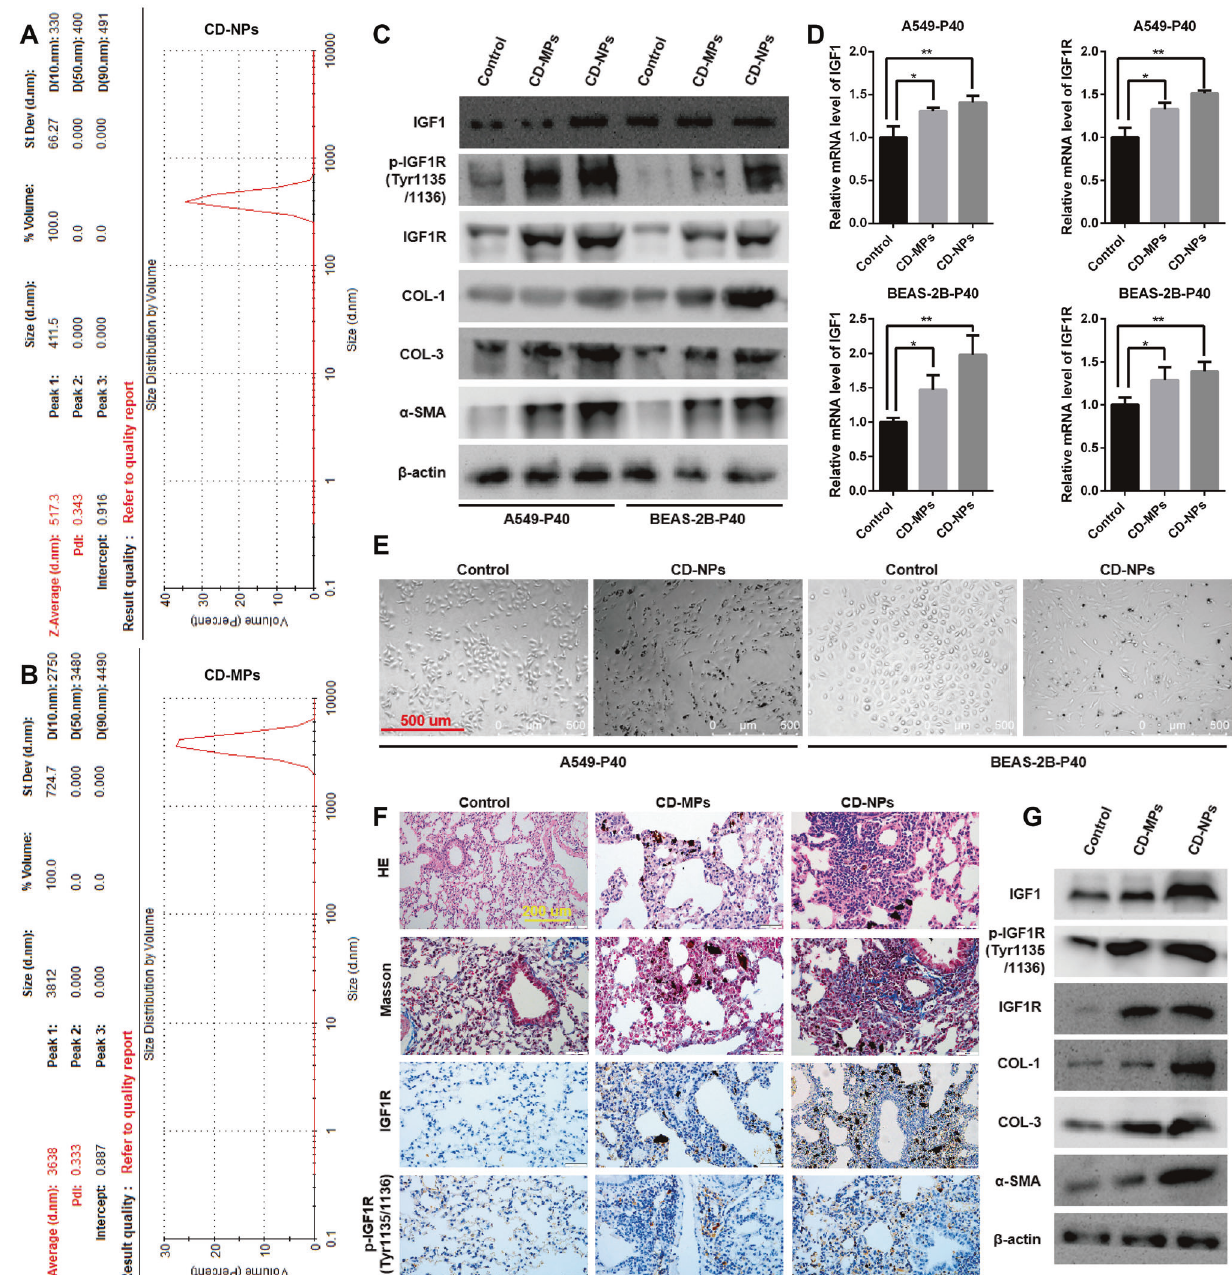
Fig. 2 IGF1/IGF1R signaling is signi fi cantly activated in models of pre- fi brosis in vitro and in vivo. A , B The size distribution and polydispersity index (PDI) of CD-MPs and CD-NPs were measured with a Malvern Nanoparticle Size Potentiometer. C , D IGF1/IGF1R signaling was detected by western blot and qRT-PCR in models of pre- fi brosis in vitro. E Cell morphology in an in vitro pre- fi brosis model was examined by inverted microscope. F , G IGF1/IGF1R signaling was detected by immunohistochemistry and western blot in models of pre- fi brosis in vivo. increased in CD-NPs-induced pre- fi brosis model cells and animal lung tissues, whereas the EMT marker molecule E-cadherin was Fig. 4B, D (the protein expression level of HO-1 follows the same decreased. After 24 h of PPP intervention, N-cadherin and TGF β 1 trend as the intracellular ROS content). In vivo, compared with the were decreased, and E-cadherin was increased. In addition, control group, the production of ROS in lung tissue cells of CD- treatment of AECs with recombinant human IGF1 for 24 h induced NPs-induced pre- fi brosis model mice was signi fi cantly increased, increase of N-cadherin and TGF β 1 and decrease of E-cadherin, and ROS production decreased after the addition of PPP (Fig. 4E). which could be reversed by NAC treatment for 24 h. Finally, the These data suggest that IGF1/IGF1R signaling activation promotes migration and invasion abilities of AECs were like the change CD-NPs-induced ROS production. in the expression levels of N-cadherin and TGF β 1 in each Furthermore, as illustrated in Fig. 4F, G, the EMT marker group (Fig. 4H, I). These results indicated that EMT occurred in molecule N-cadherin and EMT driver TGF β 1 were signi fi cantly